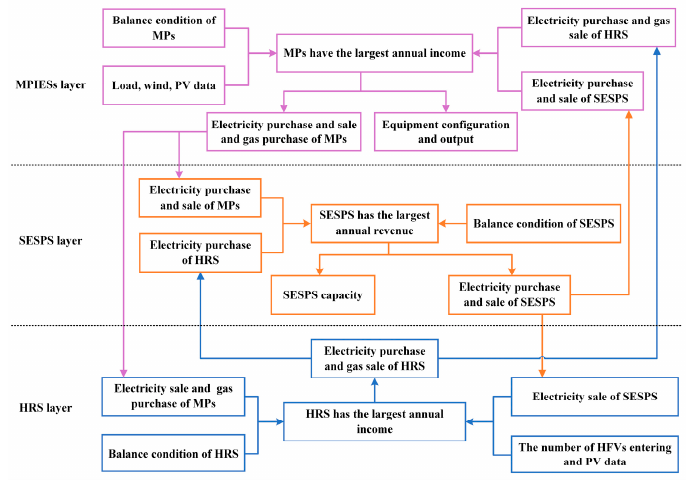
Figure 4. The three-layer configuration optimization model.